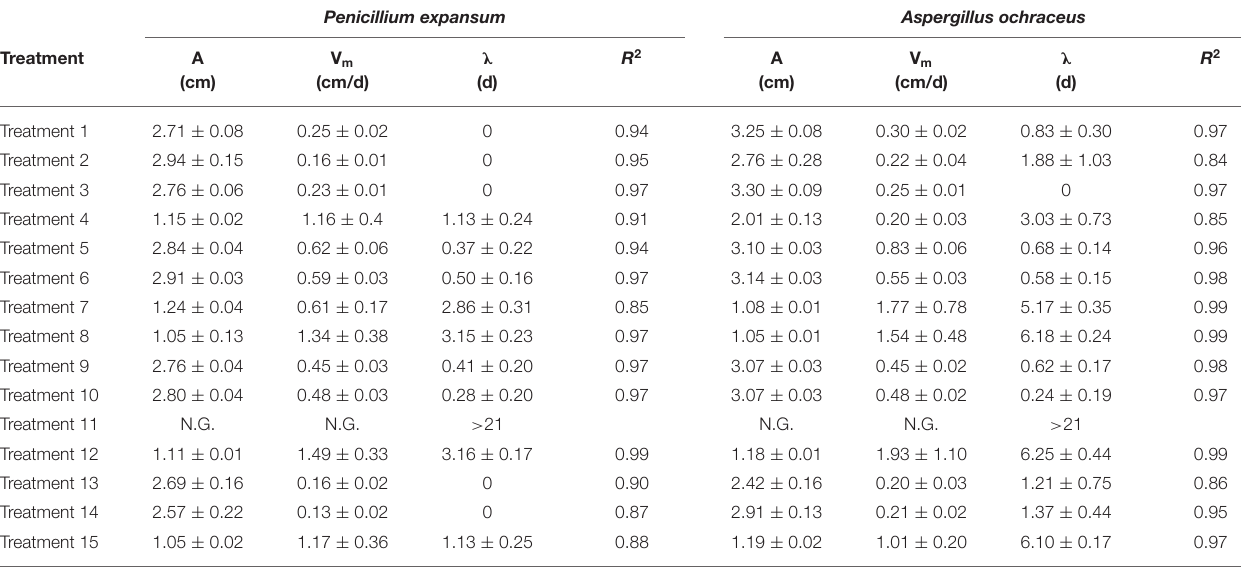
TABLE 4 | Parameters of the modified Gompertz equation for radial growth of Penicillium expansum and Aspergillus ochraceus , using Lippia berlandieri Schauer essential oil with high thymol content in combination with pH and protein content.